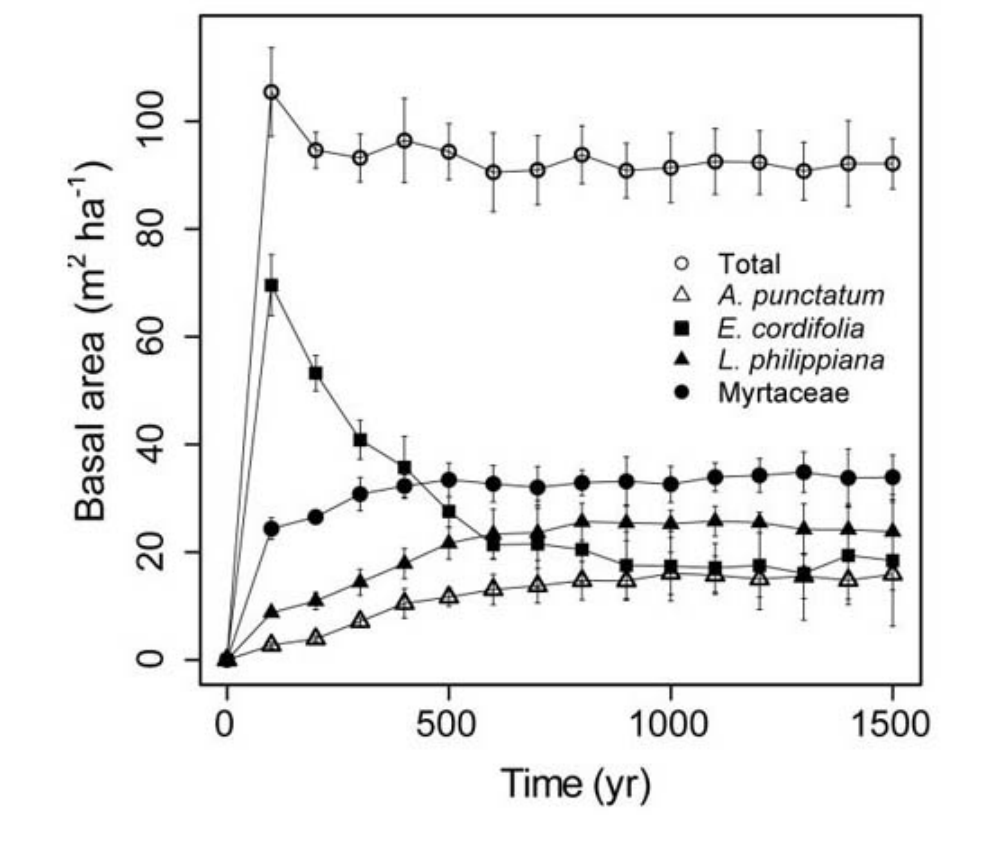
Fig. 6. Simulation of regeneration of Valdivian temperate rain forest in northern Chiloé Island, Chile, after large-scale disturbance. Mean and standard deviation of basal area of the different tree species for 10 simulations for 1 ha and 1500 years (individuals ‡ 5 cm dbh). Note that the first 400 years of succession were dominated by Eucryphia cordifolia , which was then replaced by more shade-tolerant species such as Laureliopsis philippiana and Aextoxicon punctatum